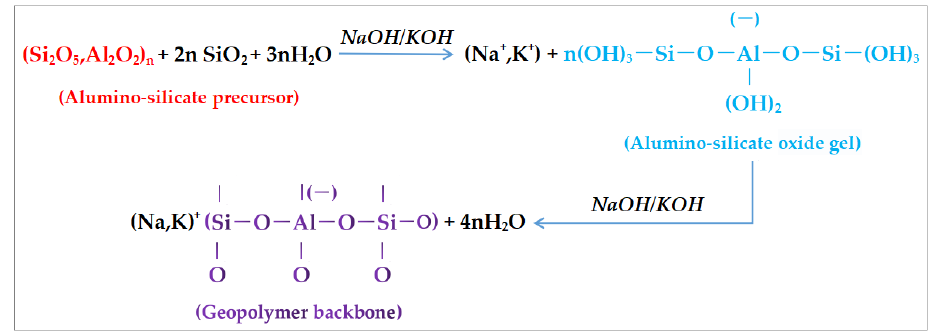
Figure 3. Expression of reaction mechanism of geopolymer.